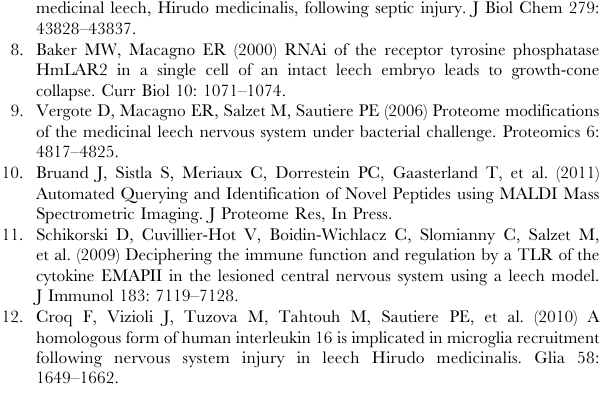
Figure S1 The m/z 2475 ion is not expressed in control adult CNS segmental ganglia. A . MALDI-MS average spectrum acquired from 9 sections of the non regenerating adult ganglion. The ion with m/z 2475 is not detected in control ganglion sections (labeled by the red cross). B . Distribution of the m/z 2475